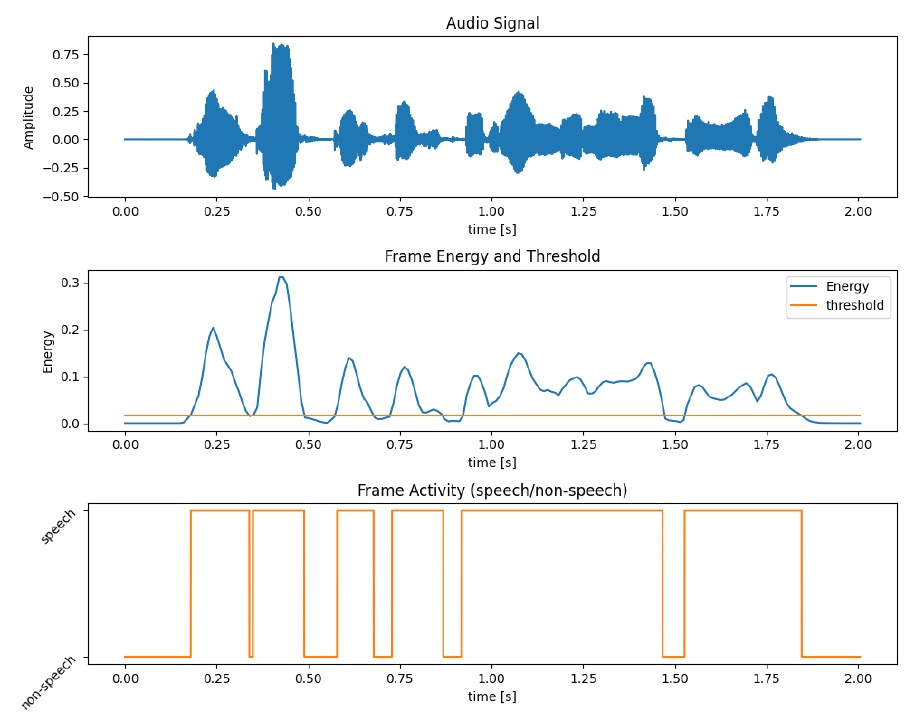
Figure 5. Example of Voice Activity Detection (VAD) algorithm functioning. On the top, the audio signal. On the center, the energy of the signal and the selected threshold (5% of maximum energy). On the bottom, the VAD output, speech and non-speech